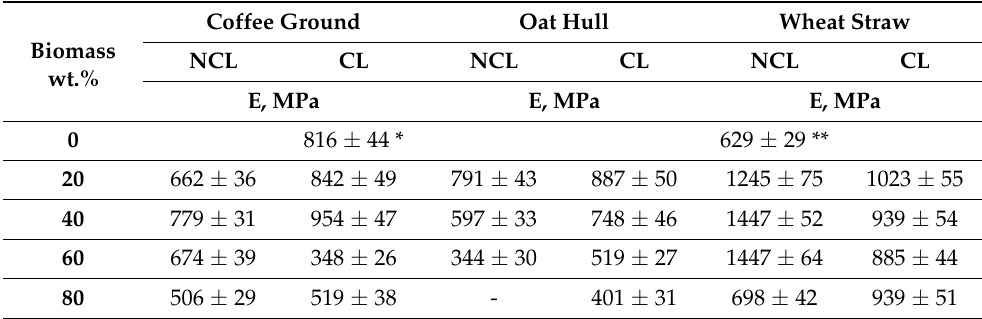
Table 3. Young’s moduli of dry chitosan-based agro-waste pellets in their crosslinked (CL) and non-crosslinked (NCL) forms in the dry state.